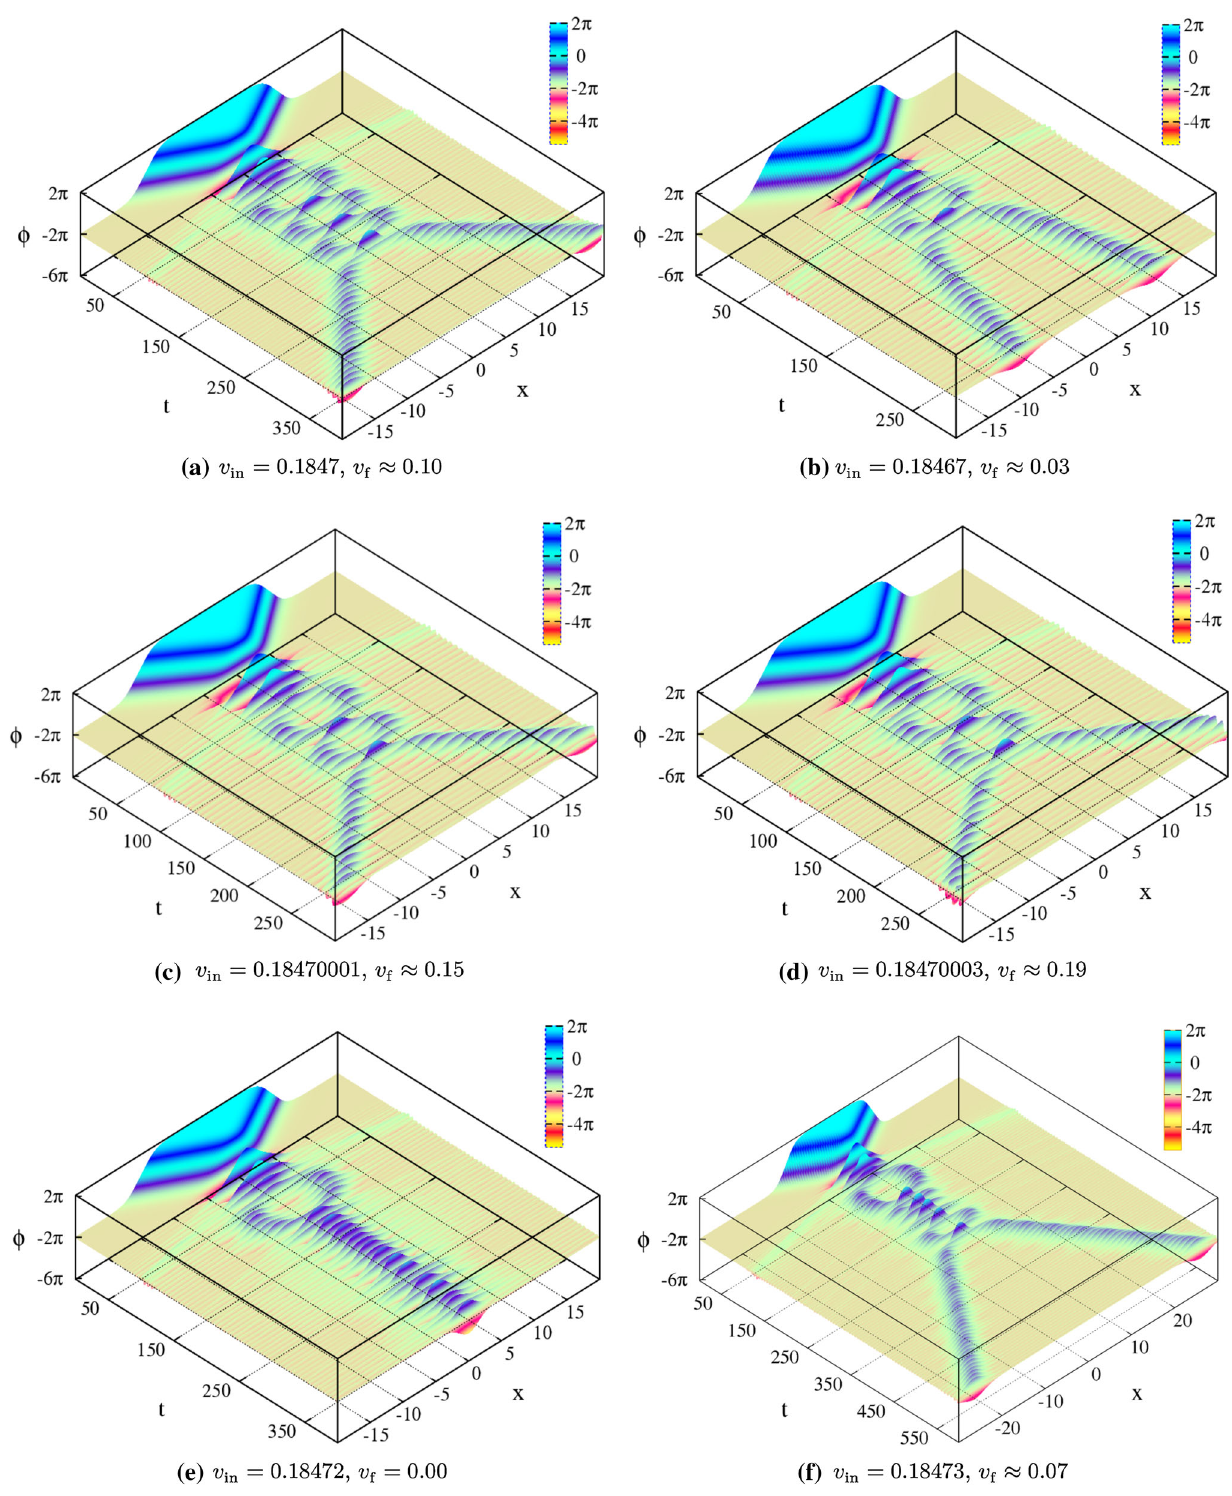
Fig. 7 Kink–antikink collisions at various initial velocities ( R = 1, ξ = 10) and escape of